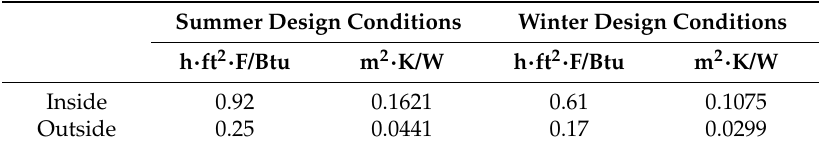
Table 3. Thermal Resistance of Air Films in contact with the inside and the outside surfaces of the